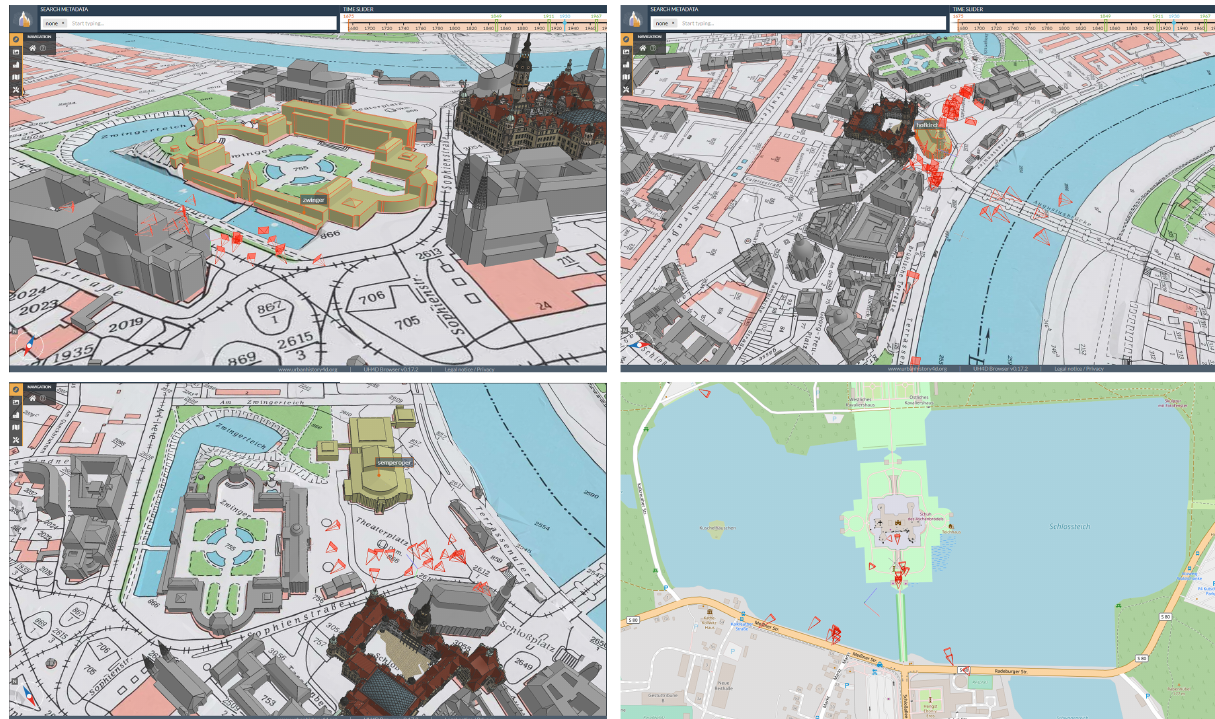
Figure 7. Reconstructed camera positions and orientations (small red frustums) derived by COLMAP manually blended into 3D/4D environment of 4D-browser (https://4dbrowser.urbanhistory4d.org/, accessed on 20 September 2021 for better scene understanding. Since there is no 3D model of Schloss Moritzburg yet, the OpenStreetMap [53] representation is